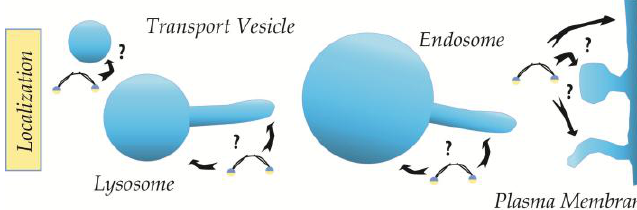
Figure 1. Different membrane geometries recruiting intracellular proteins. Protein recruitment to different membrane compartments with different local curvatures are exemplified here with N-BAR (BAR domains containing N-terminal amphipathic helices) proteins containing crescent shaped BAR domain dimers and amphipathic helices ( blue / yellow ). Arrows indicate potential sites of protein-membrane interactions.